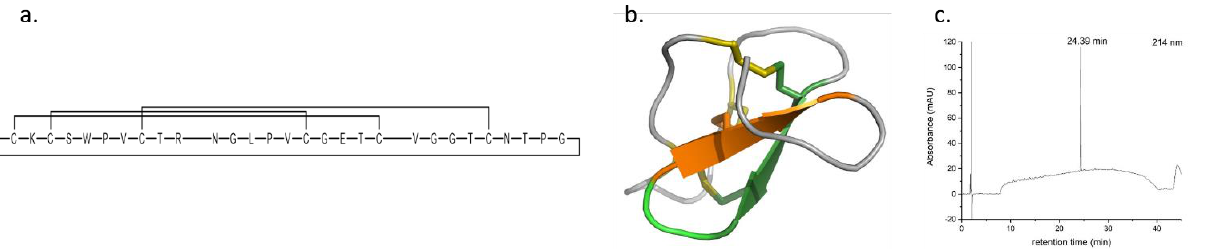
Figure 29. T20K ( a ) sequence and ( b ) crystal structure (PDB: 1NB1) and ( c ) HPLC chromatogram of pure T20K.